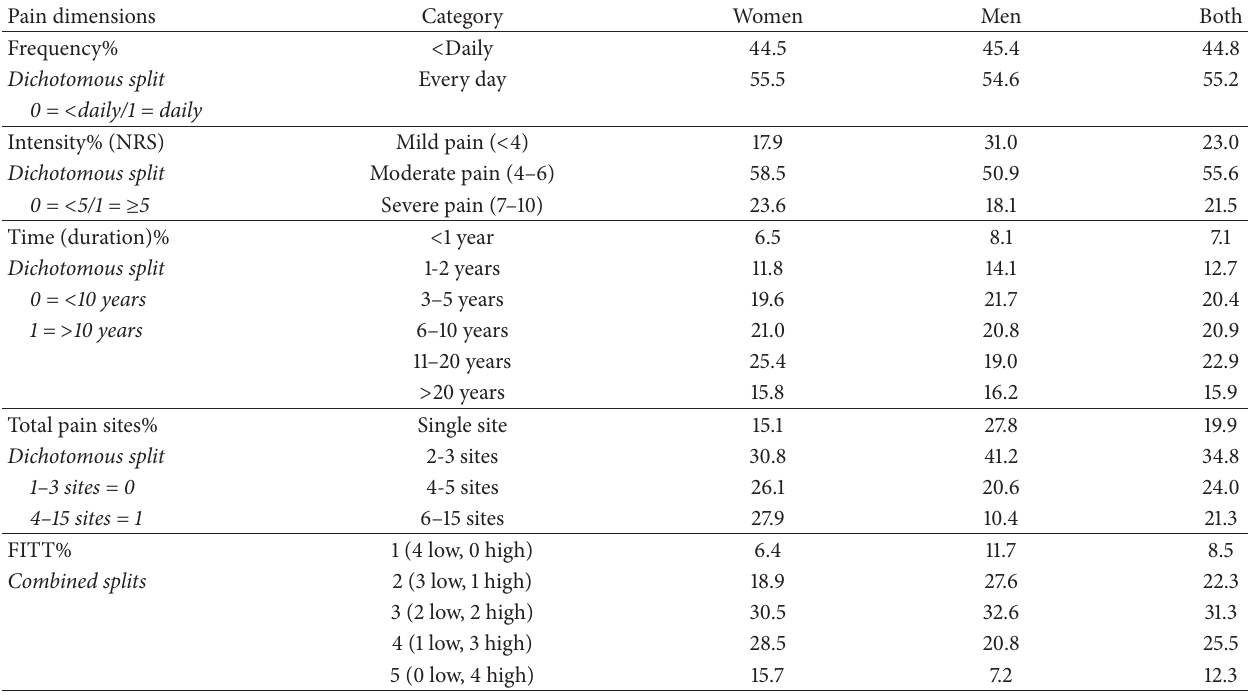
Table 2: Pain dimensions: frequency, intensity, time, total pain sites, and chronic pain severity